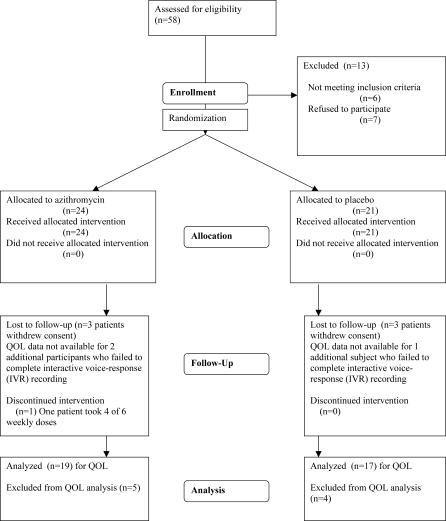
Study Flowchart